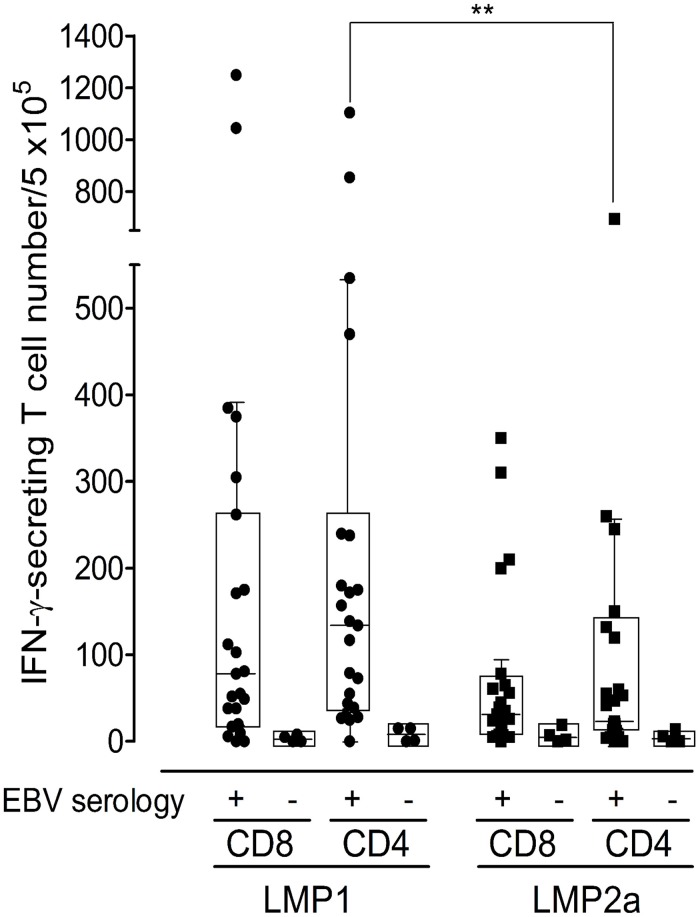
Frequency of LMP1- or LMP2a-specific CD8+ and CD4+ T cell responses of healthy Korean donors.Monocyte-derived DCs isolated from peripheral blood mononuclear cells (PBMCs) from EBV-seropositive (n = 23) and EBV-seronegative (n = 4) healthy donors were evaluated in response to mRNAs for latent (LMP1 and LMP2a) EBV antigens. Results are shown as IFN-γ secreting T cell number/5 × 105 for IFN-γ ELISPOT responses. EBV-specific CD4+ T cell responses determined by the LMP1 ELISPOT assay are significantly higher than those detected by the LMP2a ELISPOT assay (p = 0.0067, two-tailed Mann-Whitney test). Box and whisker plots (Tukey’s test; 25% ~ 75%) indicate median (middle line in the box) of EBV-specific T cell responses in individuals.